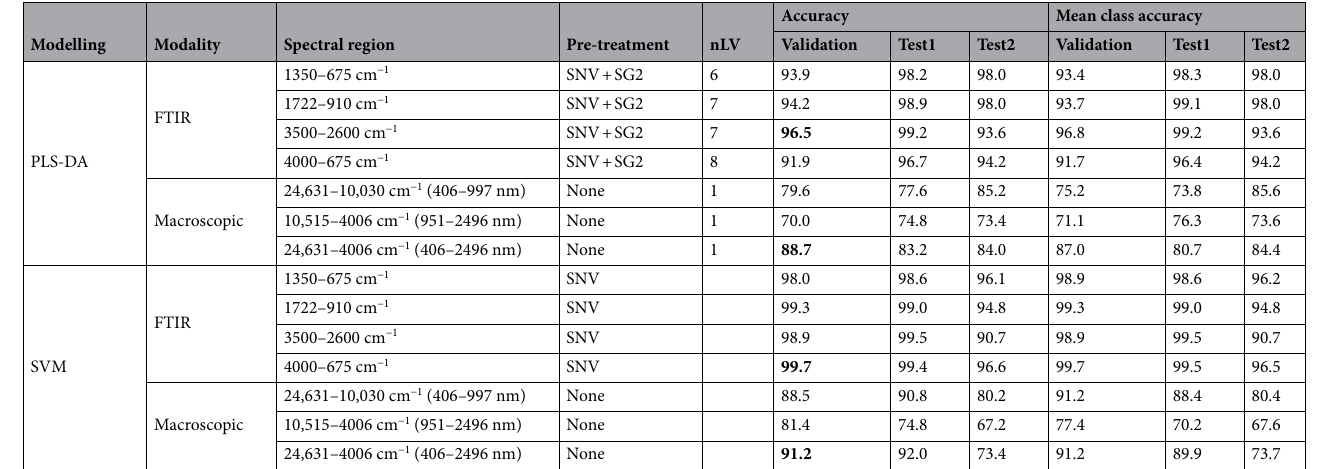
Table 3. Model performances for discrimination between Gram-positive and Gram-negative types based on pixel spectra. For each modality/spectral region, the model yielding maximum accuracy in the validation set is